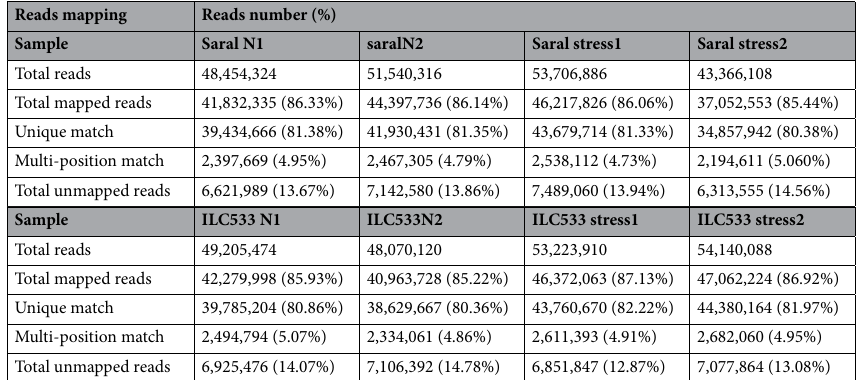
Table 1. Summary of Illumina transcriptome reads mapped to the reference